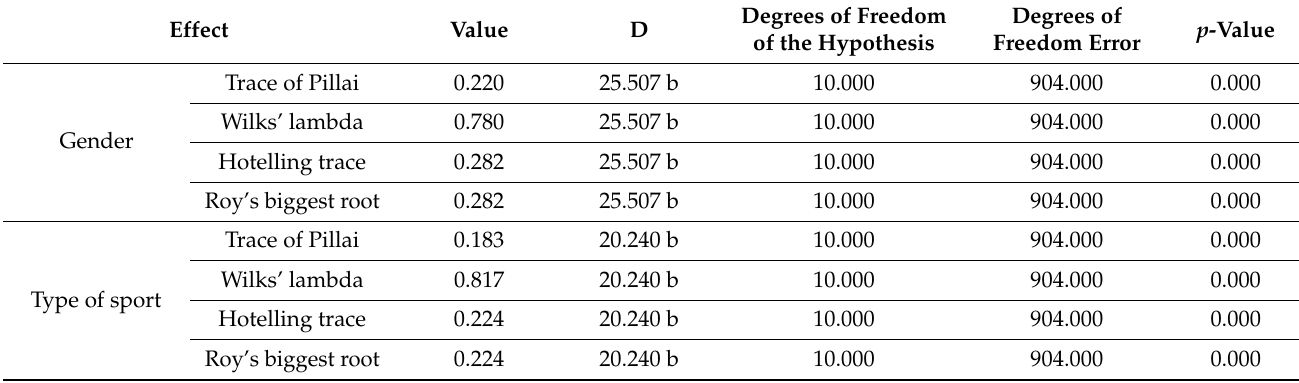
Table 1. The effect of the interaction between gender and type of sport factors on the coping strategies used by young Tunisian athletes.